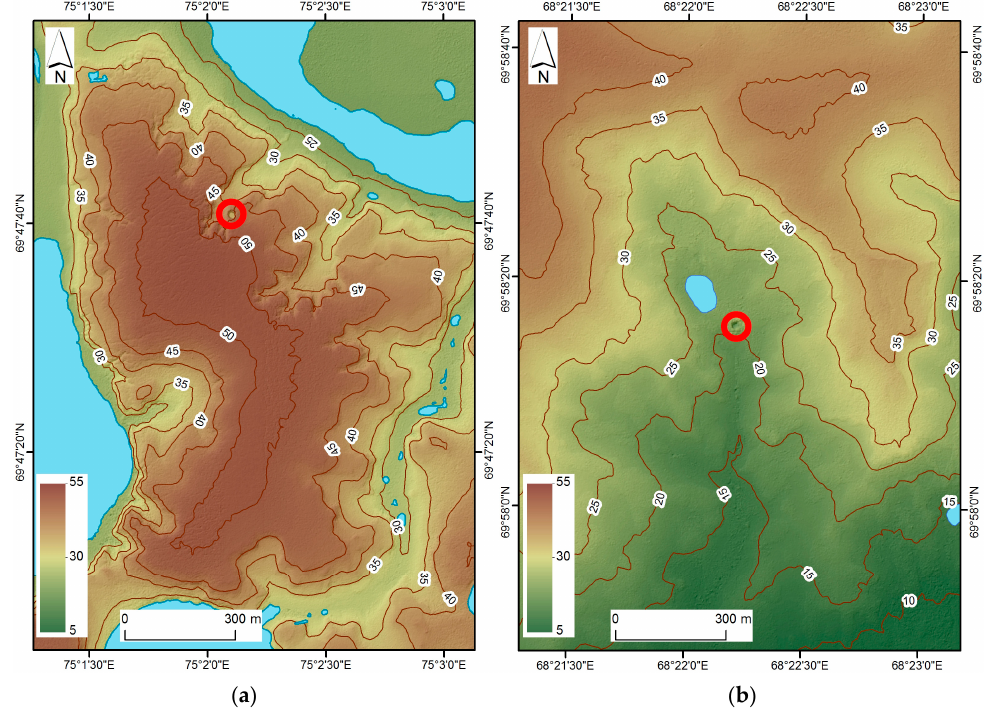
Figure 4. Differences in the crater location: ( a ) AntGEC is confined to the edge of the terrace remain and upper slope. The slopes of the third terrace remains are cut by erosion gullies, and separated by thermokarst basins; ( b ) GEC-1 is located at the foot of a gentle slope near the border of the khasyrey (drained lake bottom).